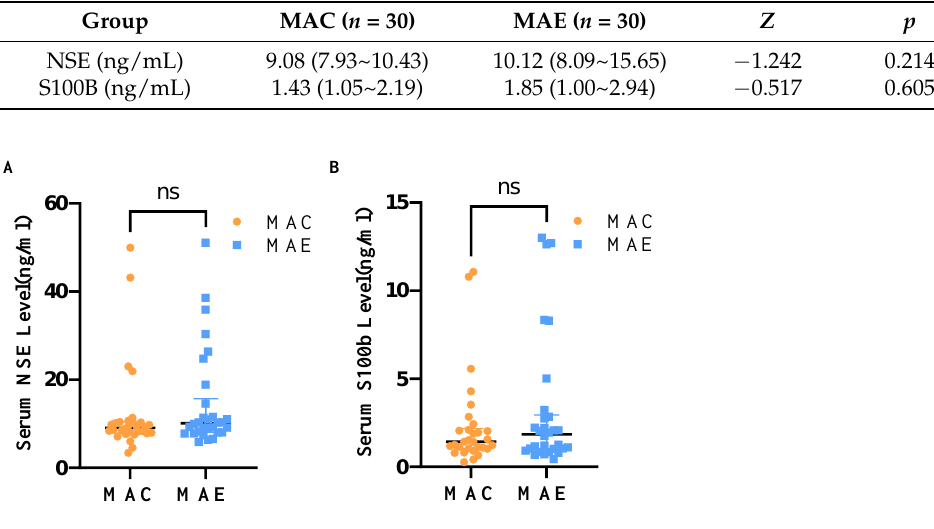
Figure 2. Serum NSE and S100b levels in MAE and MAC groups. ( A ): Serum NSE levels in the MAC Figure 2 . Serum NSE and S100b levels in MAE and MAC groups. A: Serum NSE levels in the and MAE groups; ( B ): Serum S100b levels in the MAC and MAE groups. ns: There was no significant MAC and MAE groups; B: Serum S100b levels in the MAC and MAE groups. ns: There was no difference in Serum NSE and S100b in the MAE group compared with the MAC significant difference in Serum NSE and S100b in the MAE group compared with the MAC group.